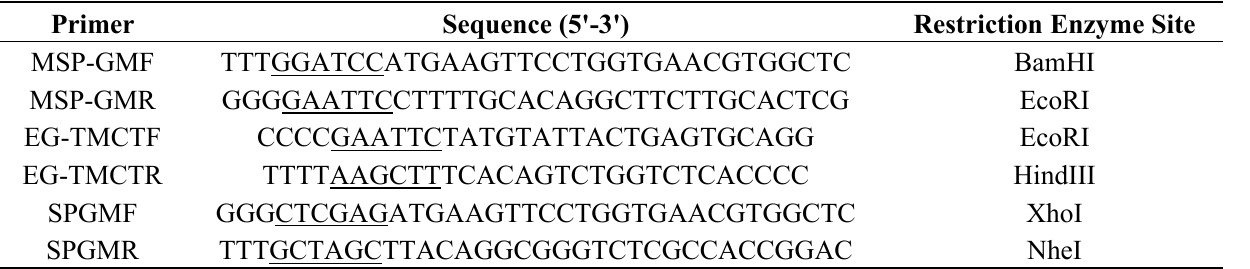
Table 1. Sequences of primers used in present